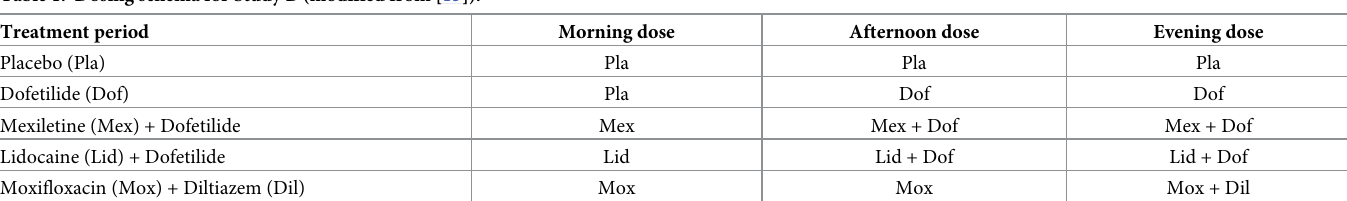
Table 1. Dosing schema for Study B (modified from